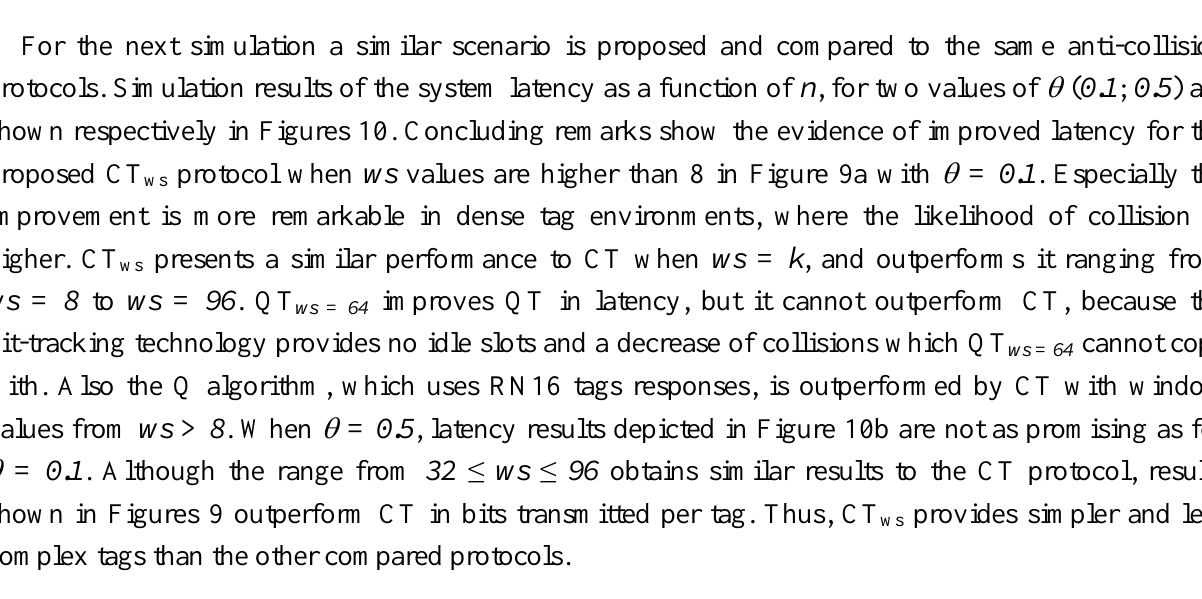
Figure 10. Simulated results of the system latency with various groups of tags compared